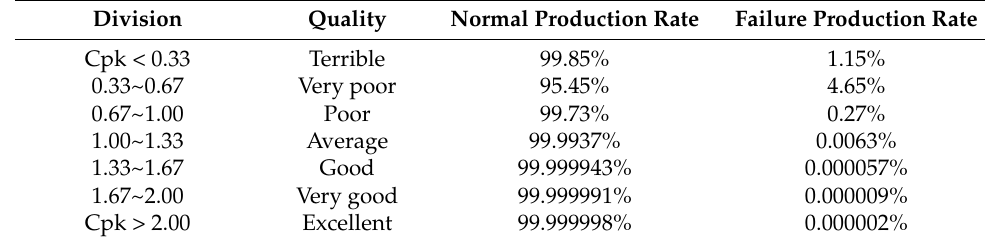
Table 2. Criteria of process capability index, Cpk.